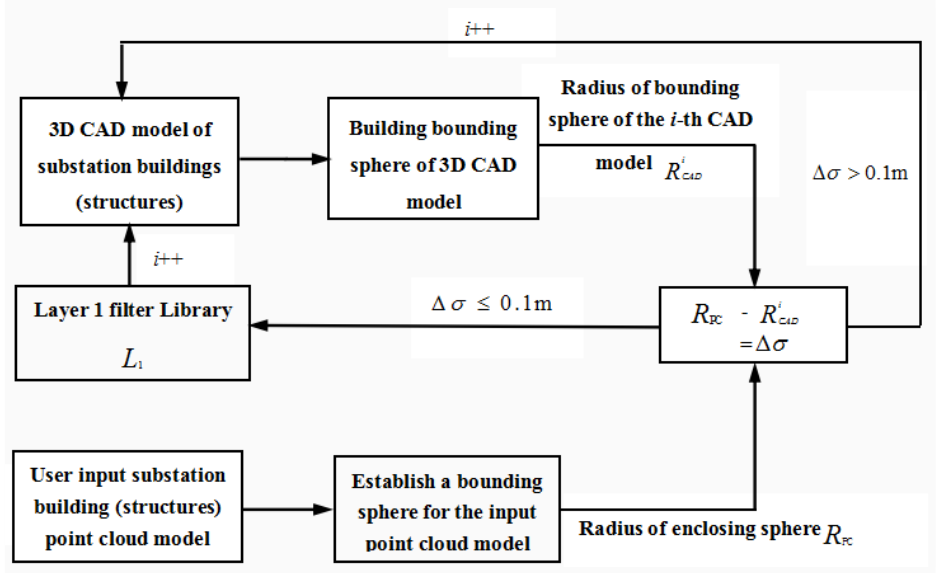
Figure 3. Model screening based on bounding sphere.